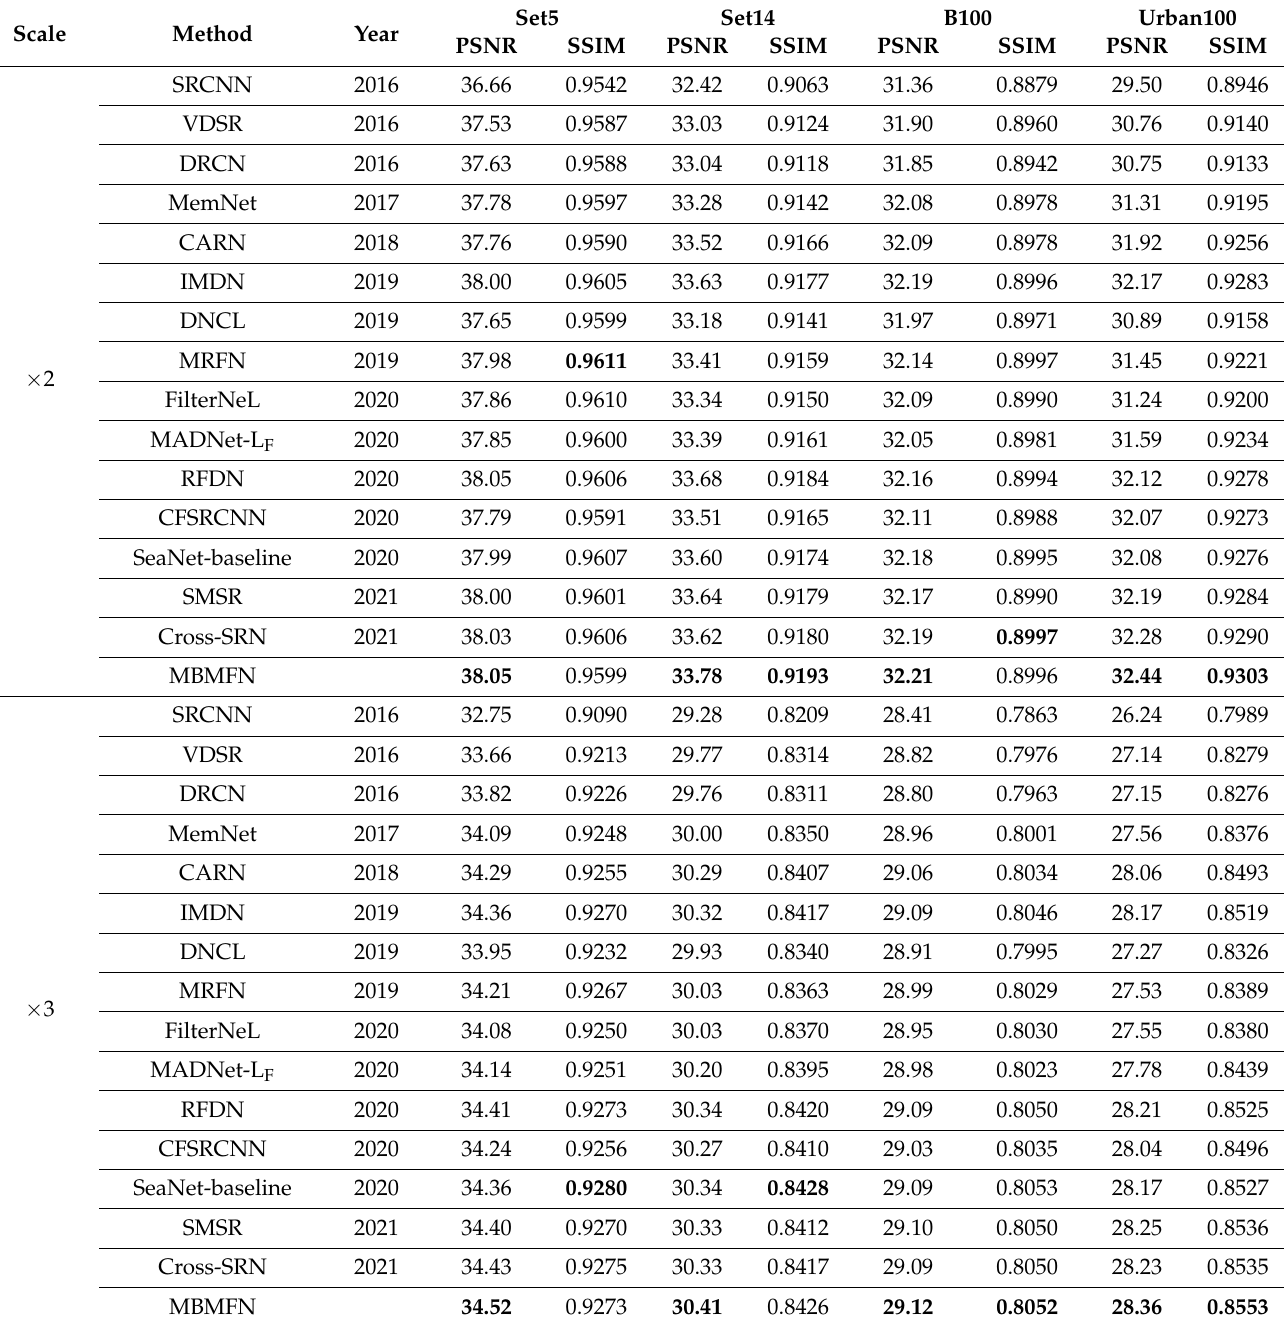
Table 4. Average PSNR/SSIM of BI degradation models × 2, × 3 and × 4, and the optimal results are shown in